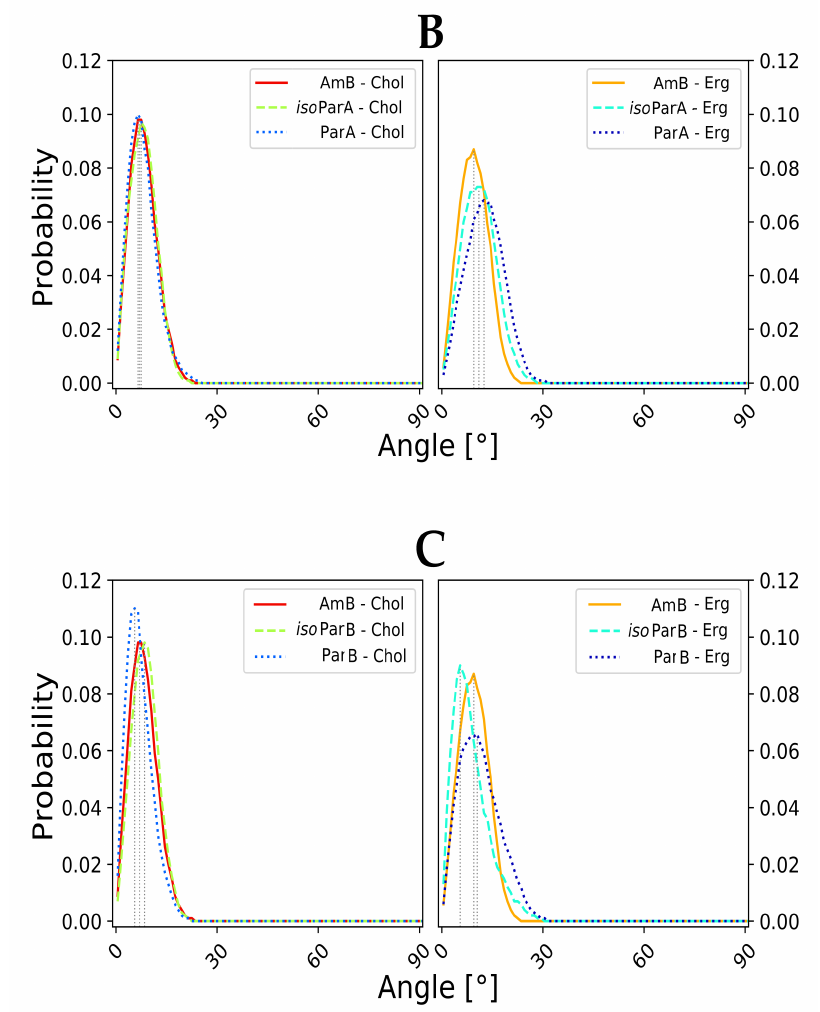
Figure 3. Distribution of angles, defined as variation of major axis of macrolactone ring of a given antibiotic in relation to the membrane normal (Z axis, perpendicular to lipid bilayer). Average variation angle for each system is represented by vertical dashed line. ( A ) Data for Candicidin D (CndD) and iso CndD, related to Amphotericin B (AmB). ( B ) Data for Partricin A (ParA) and iso ParA, related to AmB. ( C ) Data for Partricin B (ParB) and iso ParB, related to